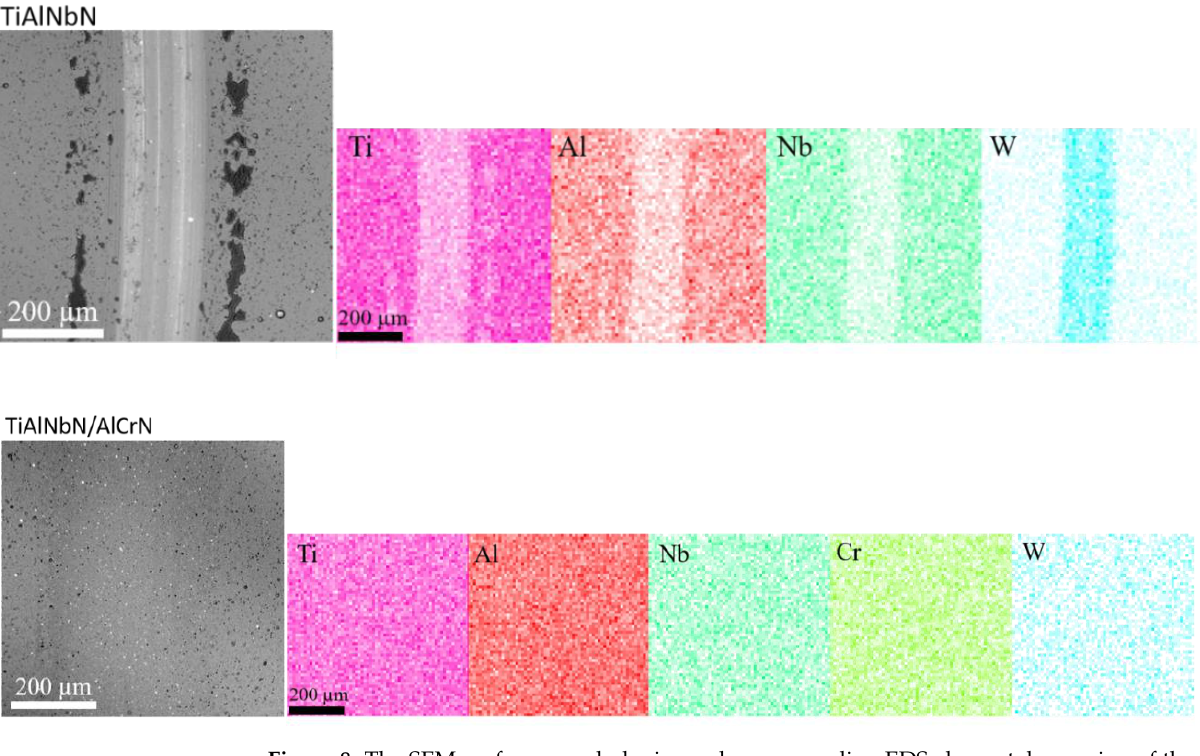
Figure 8. The SEM surface morphologies and corresponding EDS elemental mapping of the wear tracks of the TiAlNbN and multilayered TiAlNbN/AlCrN coatings after sliding distance of 500 m. Table 3. Hardness (H), Young’s modulus (E), H/E, H 3 /E 2 , coefficient of friction and wear rate of the TiAlNbN and multilayered TiAlNbN/AlCrN coatings compared with other hard coatings published in the previous